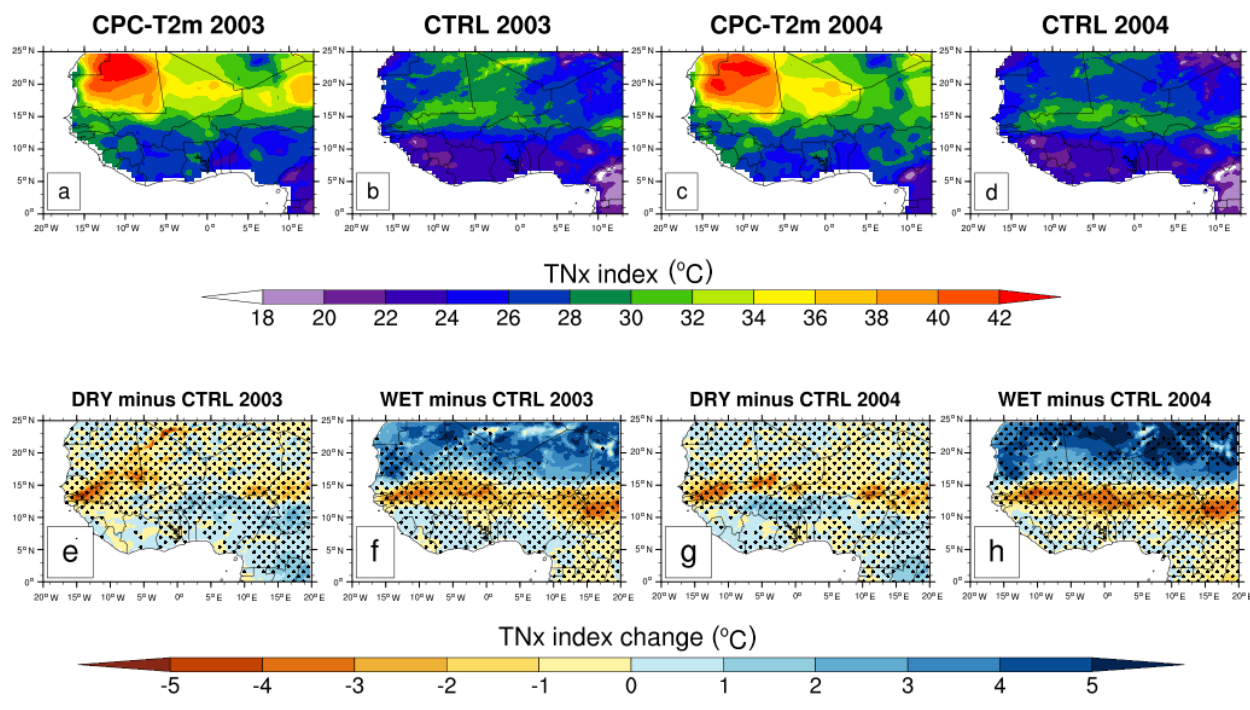
Figure 20. Same as Fig. 14 but for the TNx